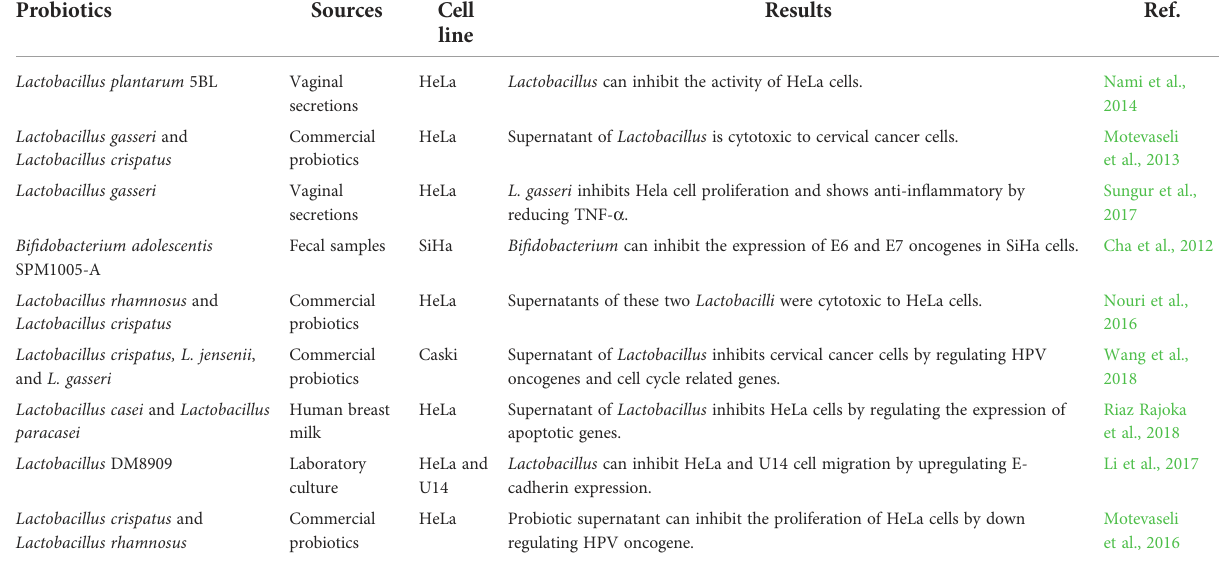
TABLE 1 Experimental studies of probiotics in cervical cancer.